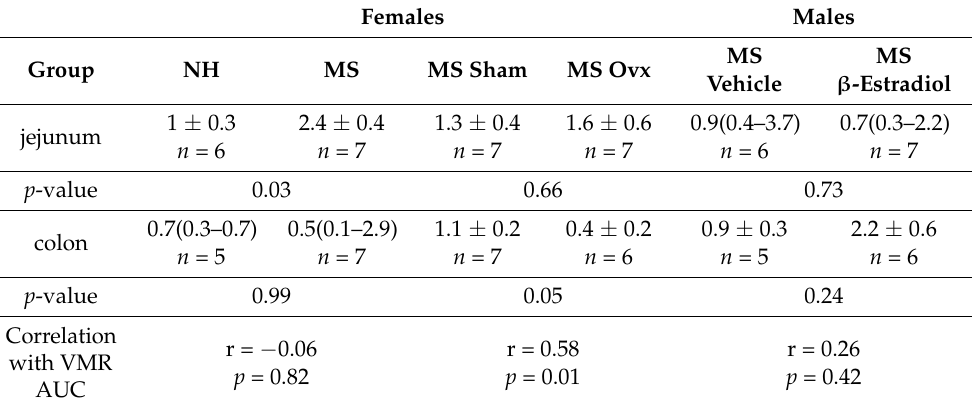
Table 3. Gene expression of the estrogen receptor gper1 in jejunum and colon